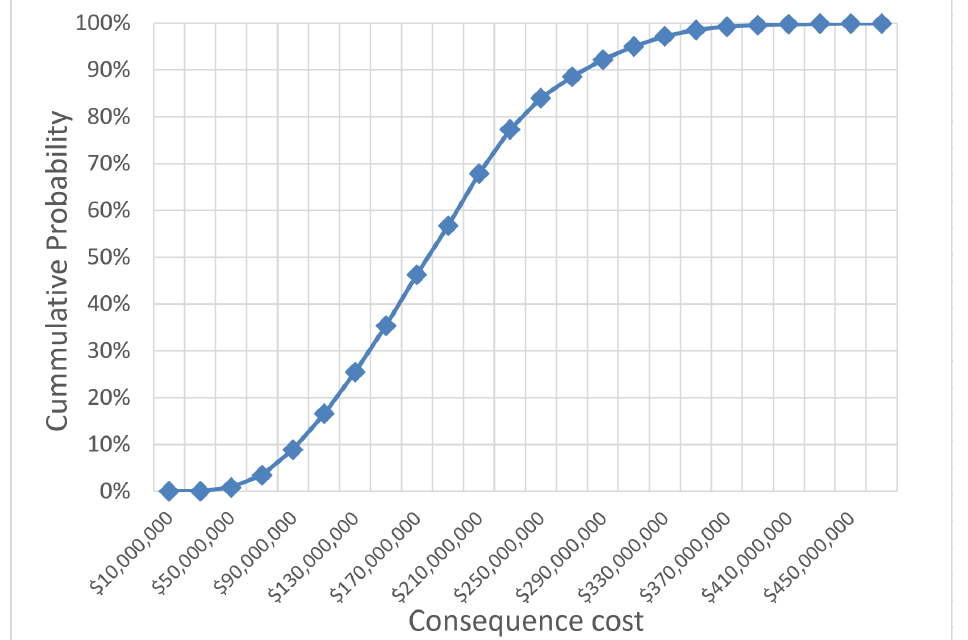
Figure 11. Cumulative probability for the outage consequence